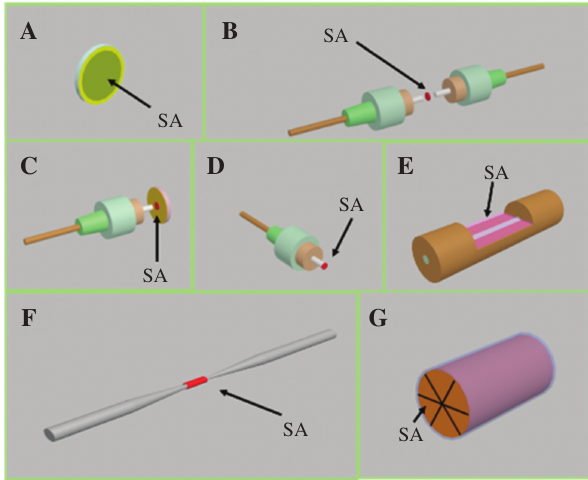
Figure 7: Incorporation schemes for 2D material saturable absorbers. (A) Transferring SA onto the substrate for free-space coupling, and sandwiching the thin-film SA between (B) two fiber connectors and (C) a fiber connector and a mirror. Transferring or depositing SA on (D) fiber end, (E) side-polished fiber, and (F) tapered fiber. (G) Filling SA into a photonic crystal